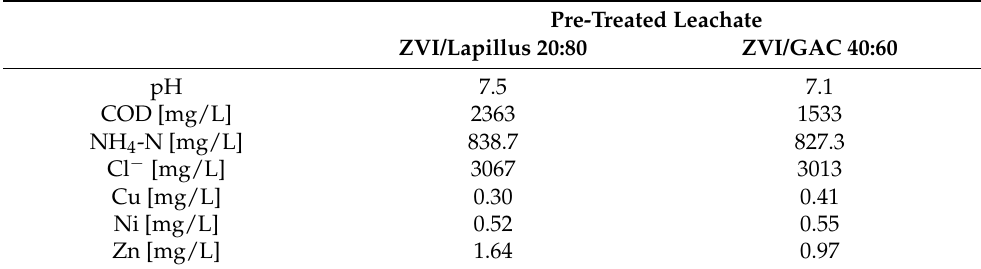
Table 2. Synthetic MLL composition used in column